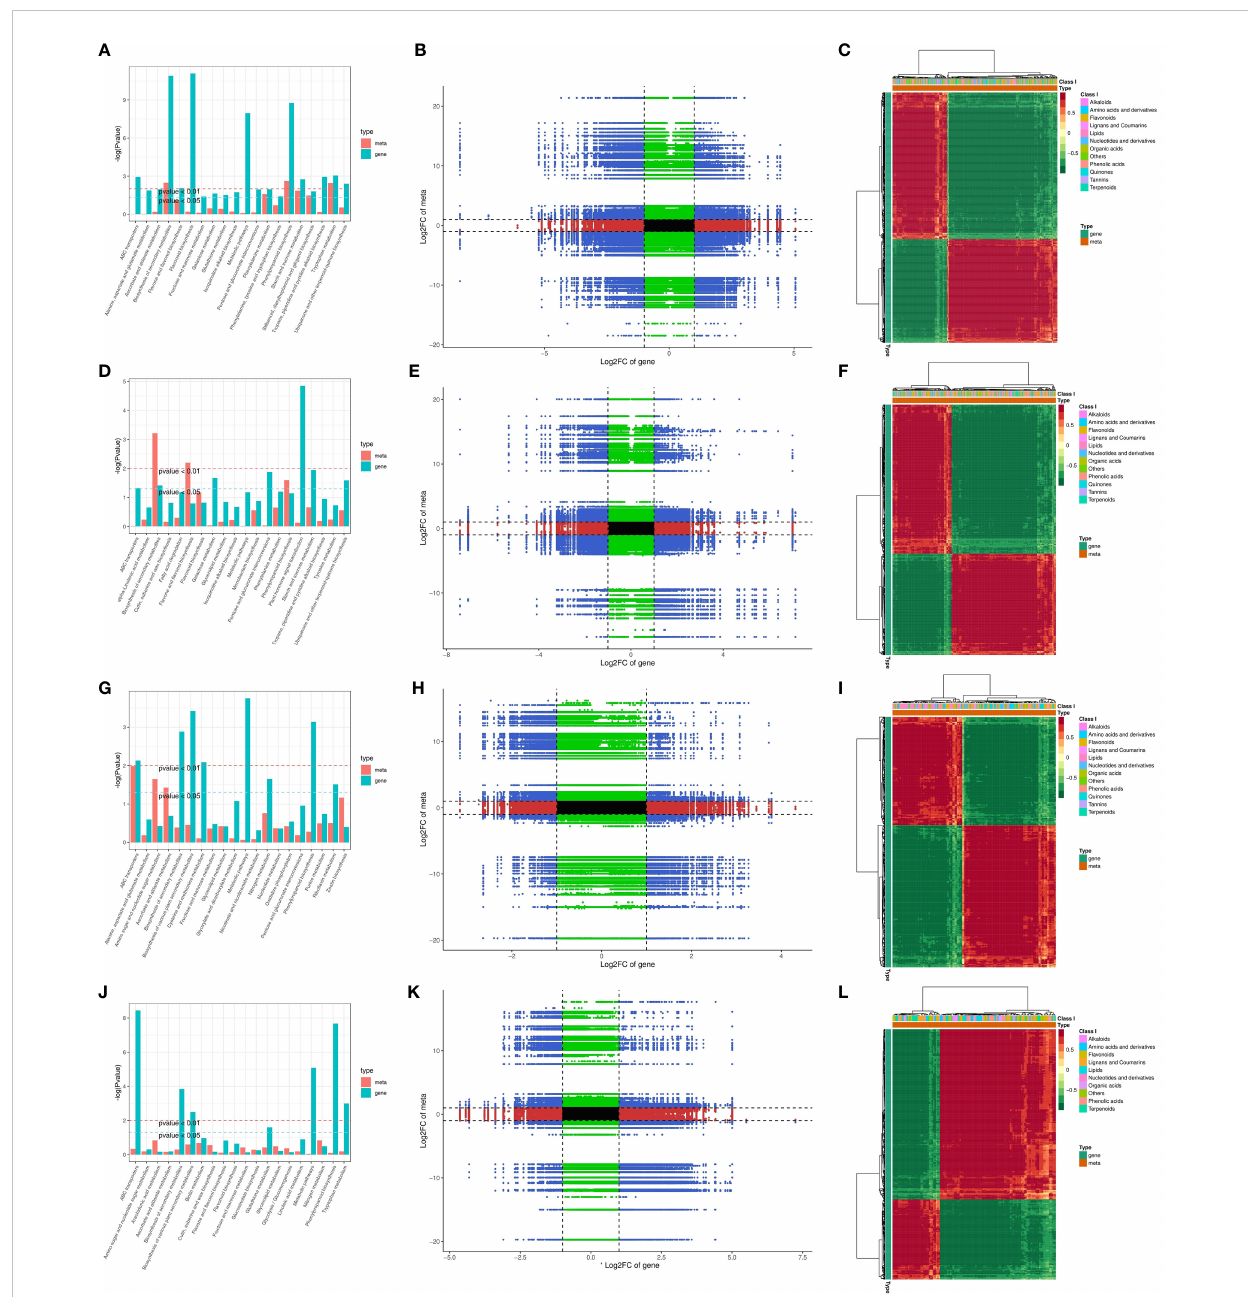
FIGURE 4 (A, D, G, J) Histograms of joint KEGG enrichment p -values, and (B, E, H, K) the associations of transcriptomic and metabolomic variation quadrant diagrams in LKL/CKL, HKL/CKL, LKR/CKR, and HKR/CKR; the black dotted lines indicate the differential thresholds. Outside the threshold lines, there were signi fi cant differences in the gene/metabolites, and within the threshold lines are shown the unchanged gene/metabolites. Each point represents a gene/metabolite. Black dots, green dots, red dots, and blue dots indicate unchanged genes/metabolites, differentially accumulated metabolites with unchanged genes, differentially expressed genes with unchanged metabolites, and both differentially expressed genes and differentially accumulated metabolites, respectively. (C, F, I, L) Heatmaps of the correlation coef fi cient clusters (>0.8), p -values <